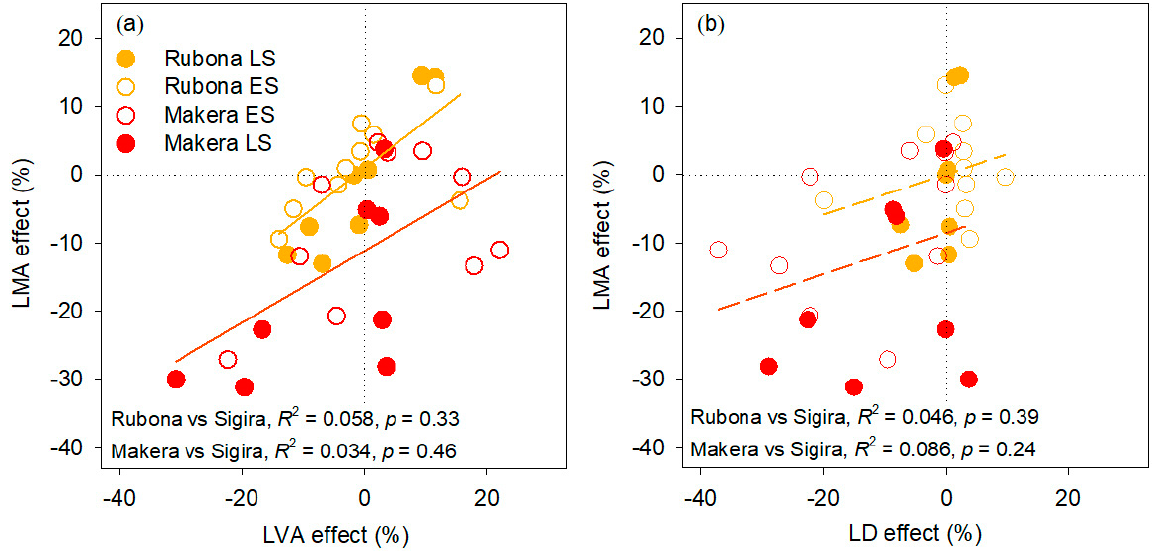
Figure 6. ( a , b ) The effect of ( a ) leaf volume per unit area (LVA) and ( b ) leaf density on leaf mass per unit area (LMA) between the mid- (Rubona) and low- (Makera) elevation versus high-elevation sites (Sigira). Each symbol represents one species, yellow, Rubona; red, Makera. Open and closed symbols, early (ES) and late (LS) successional trees, respectively. R 2 and p -values are given for the regression line of all species at a